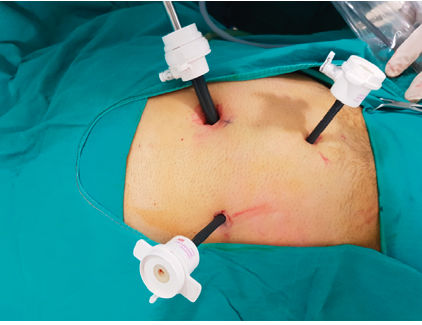
Figure 1: Placement of the trocar for laparoscopic